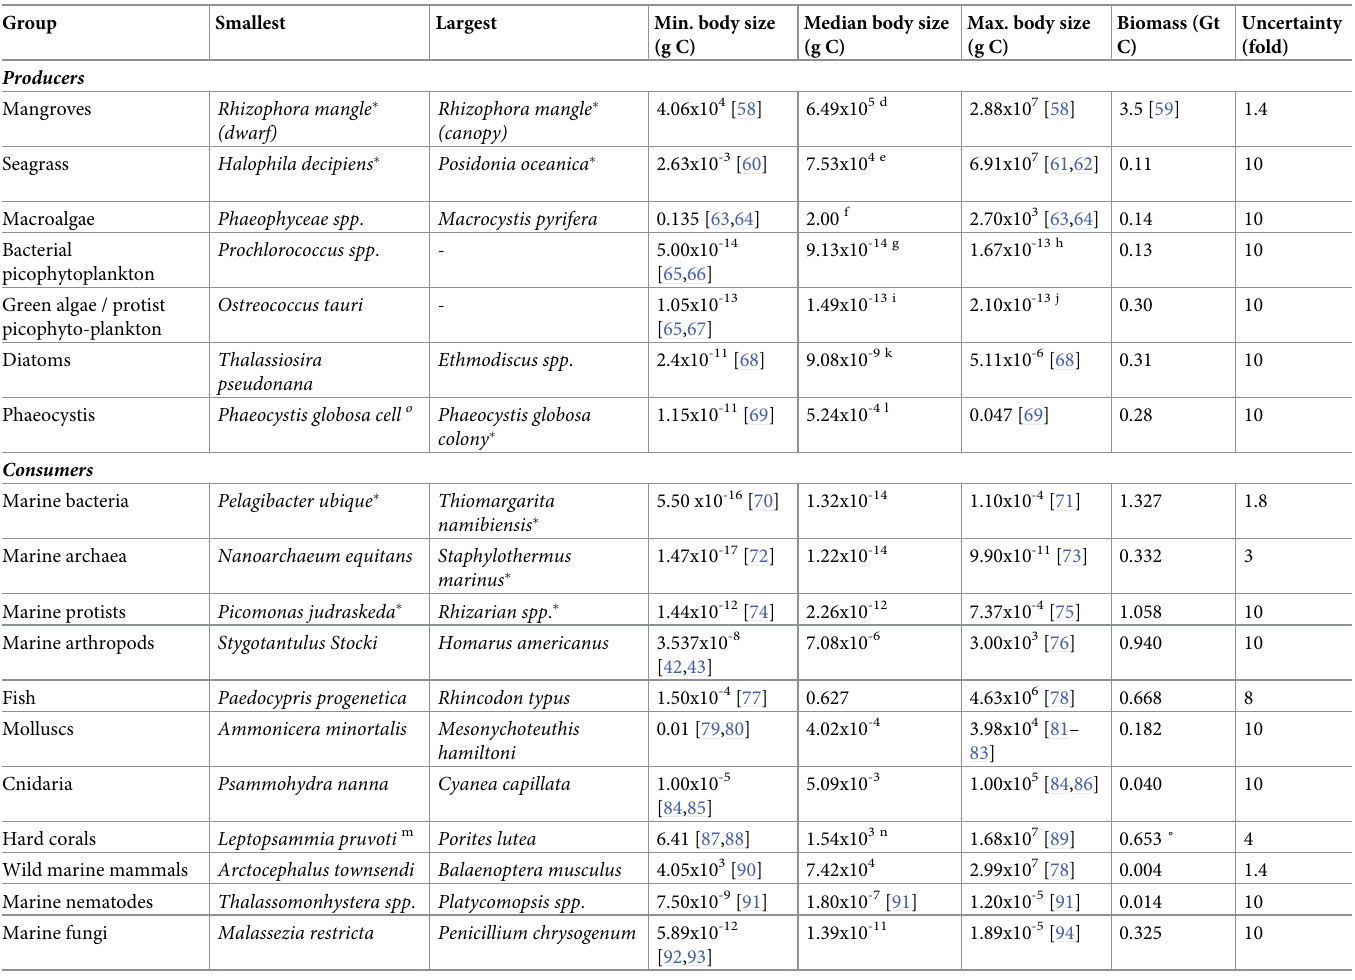
Table 3. Marine body sizes.